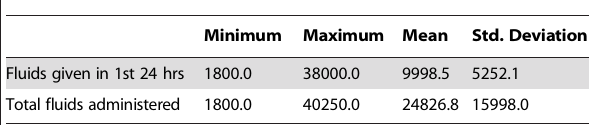
Table 2. Quantity of fluids given.